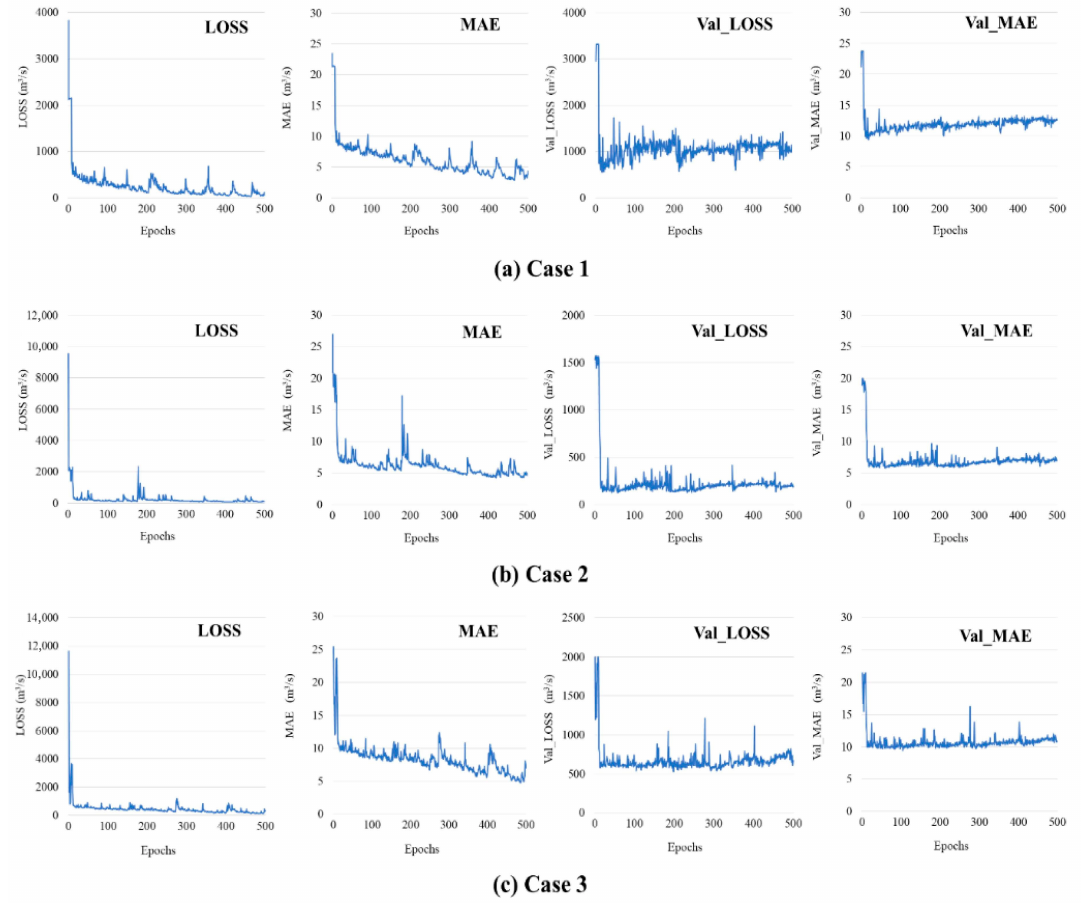
Figure 8. Training results of CNN model: ( a ) Case 1, ( b ) Case 2, and ( c ) Case 3.